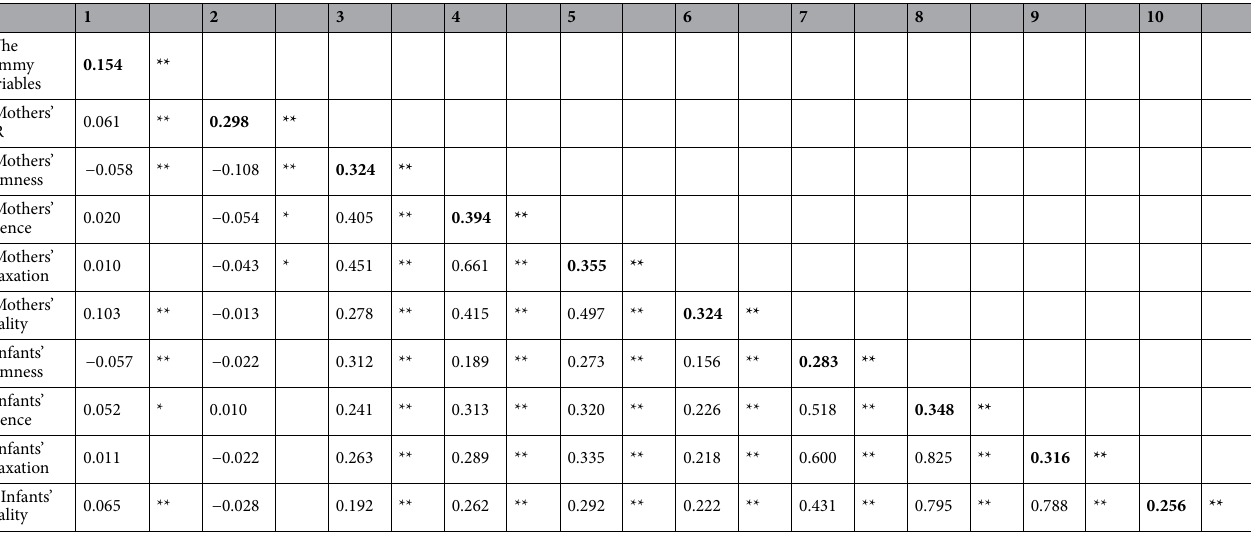
Table 1. Within-level multilevel correlation coefficients between centered dummy variables with or without the song (− 1; no song, 1; with song) and mothers’ HR and mothers’ and infants’ daily feelings when the IDS group changed diapers ( N = 2138). Intra-class correlations are on the diagonal and in bold. ** p < .01, * p <